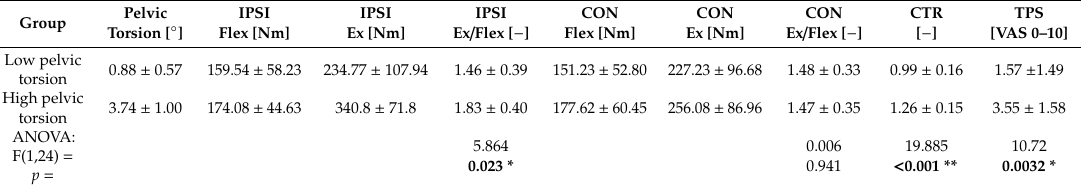
Table 2. Parameters of the subgroups with low and with high pelvic torsion. Last row: results of the